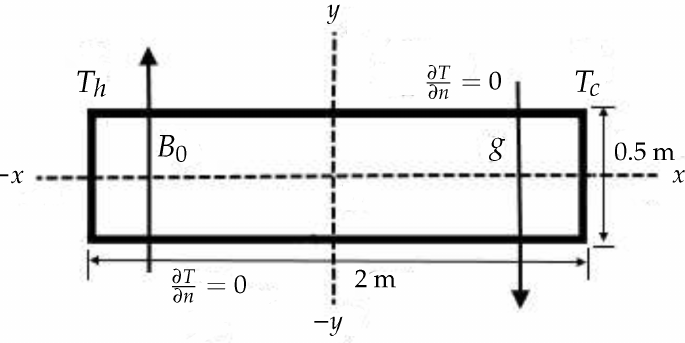
Figure 6. Schematic for the two-dimensional buoyancy-driven flow problem. The vertical walls are at constant temperature T h and T c , whereas the horizontal walls are thermally insulated. The magnetic field B 0 acts along the y -direction. The analytical solution for the non-dimensional velocity along the x -direction along the center vertical plane is [35,36]